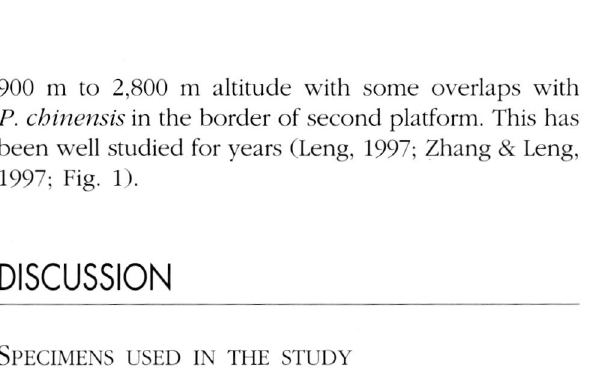
Fig.I. - Map of the zoogeographical distribution of four Chinese Adlerius phlebotomine sandflies.